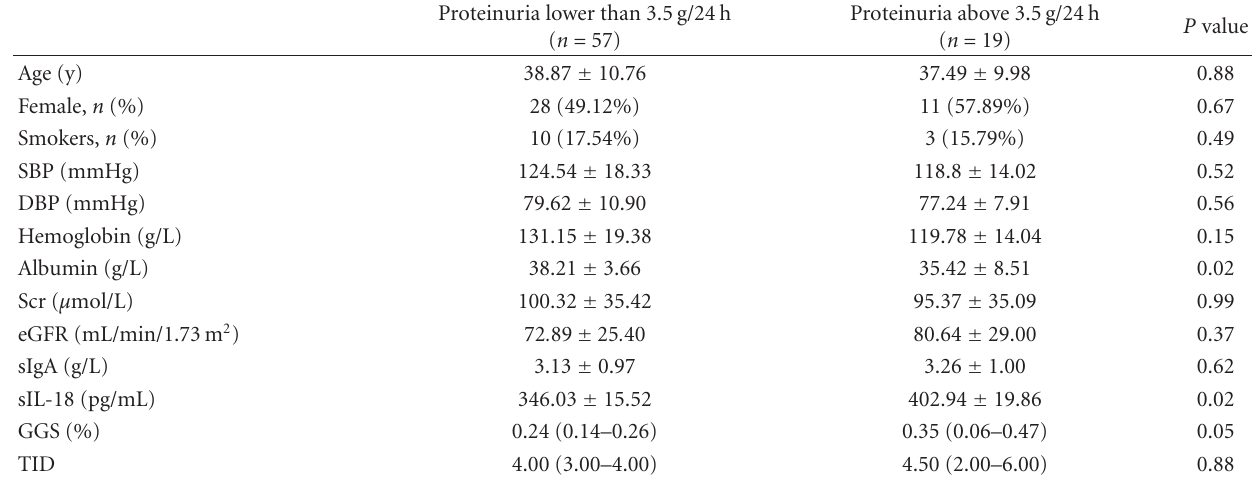
Table 4: Clinical and histological data between patients with proteinuria above 3.5g/24 h or not.